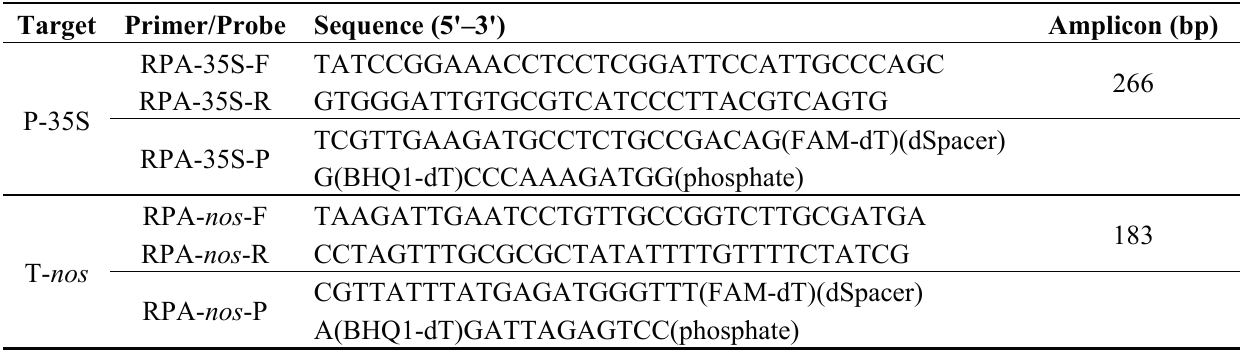
Table 2. Primers and probes used in P-35S and T- nos real-time RPA